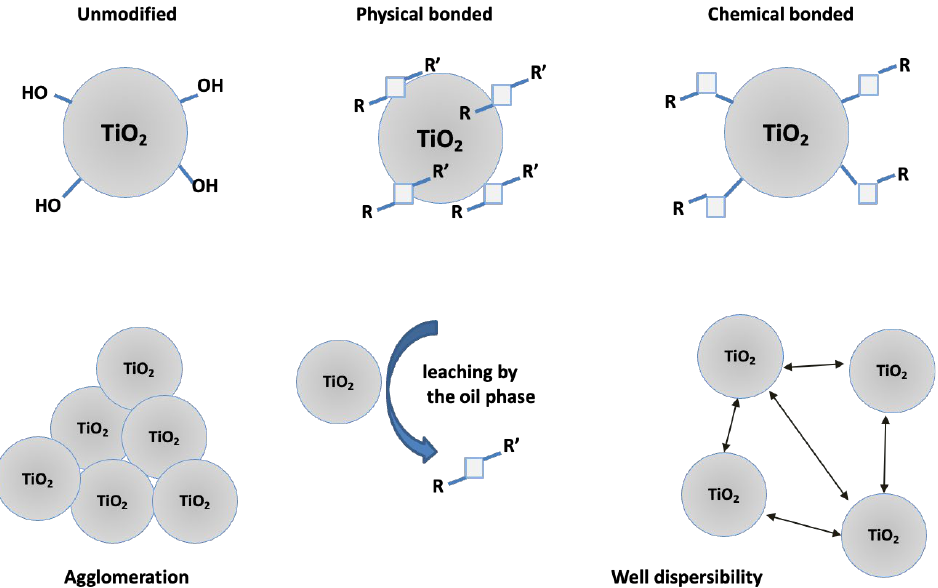
Figure 13. Interaction of SSQs (R/R’) with titanium dioxide in the colloidal system.